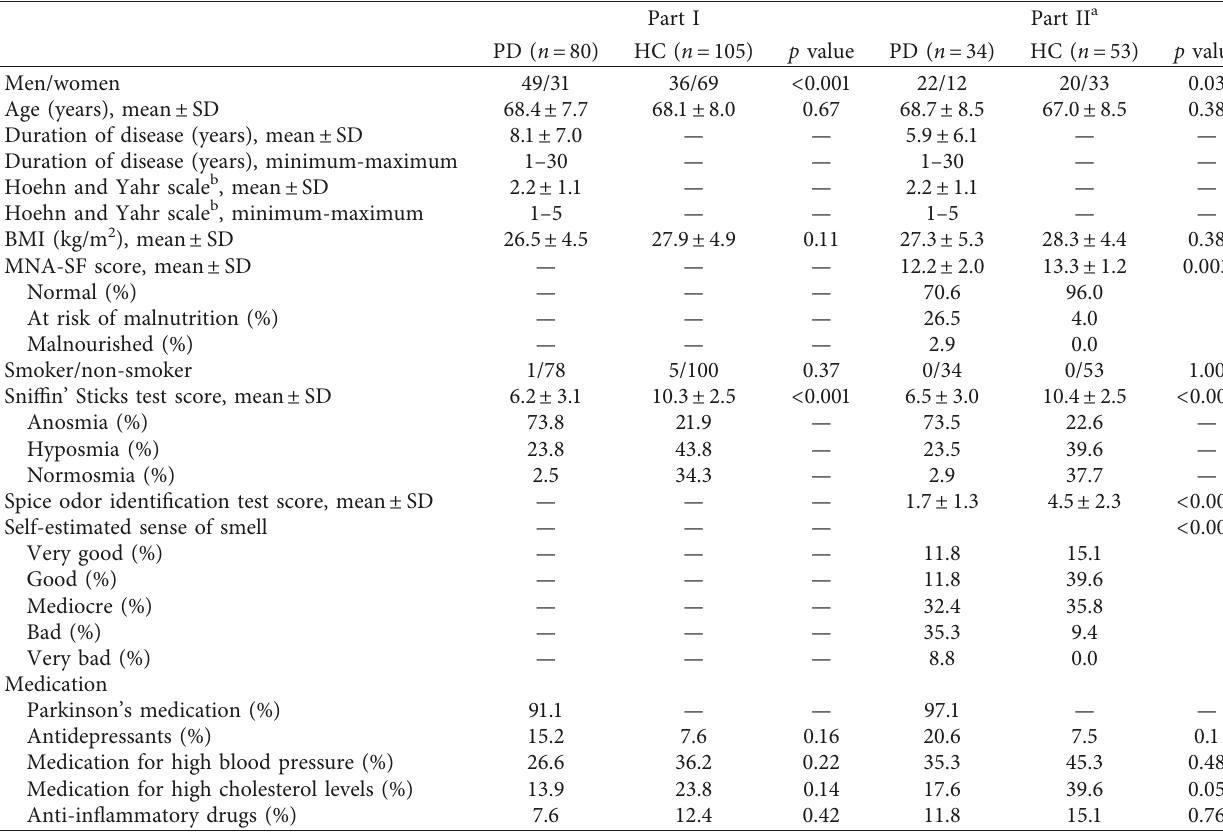
Table 1: Participants’